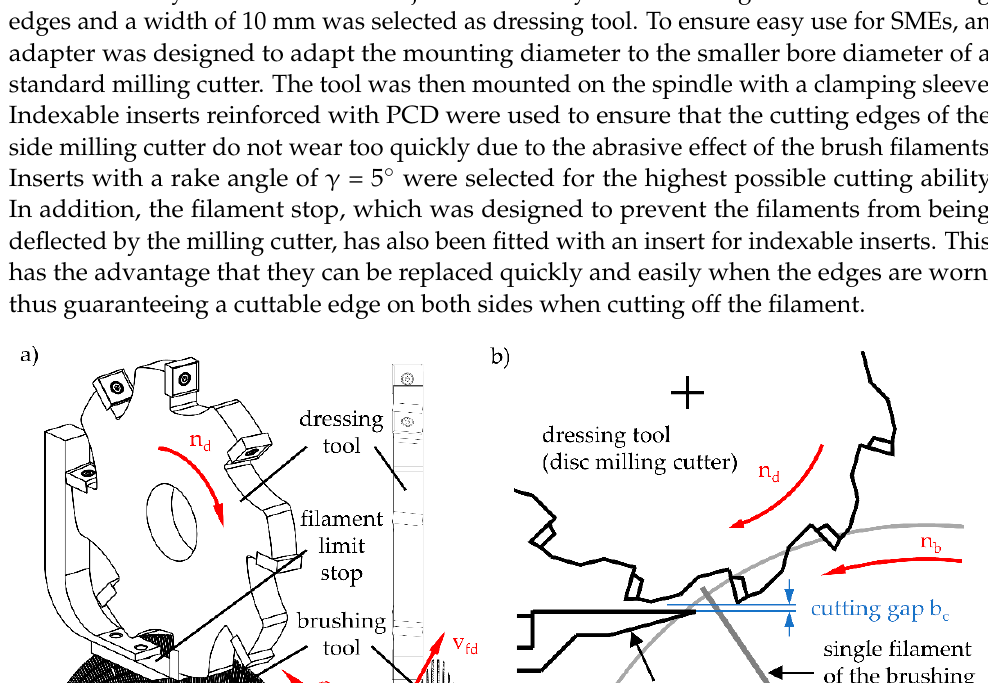
Figure 15. Front and rear views of the CAD model of the conditioning device. 3.2.2. Process Parameters and Application After the manufacturing and implementation of the designed solution, process parameters were determined. First, the size of the cutting gap b c , as well as the speeds of the brush spindle n b and the dressing spindle n d , were considered. For the width of the cutting gap b c , it was quickly determined that the smallest possible gap between the cutting edges of the side milling cutter and the filament stop leads to the best results. Since the gap is adjusted manually, the gap size is b c ≈ 0.5 mm. It was also discovered that the slower the brushing tool rotates, the better the result becomes. The lowest speed of the main spindle is limited to n min = 50 1/min. To guarantee that the brush rotates at a constant speed when engaged, the speed was set to n b = 55 1/min. The speed of the dressing tool was then varied between n d = 800 1/min and n d = 2500 1/min. A speed of n d = 2500 1/min proved to be effective based on the removed filament volume per dressing cycle. With these selected setting parameters and a dressing feed rate of v fd = 10 mm/min, a brush from the previous test series could be evenly dressed in two cycles. The dressing infeed could be adjusted in fine increments with at least a ed = 1 mm, which makes it possible to only trim the filament tips. The maximum infeed could not be clearly determined, but